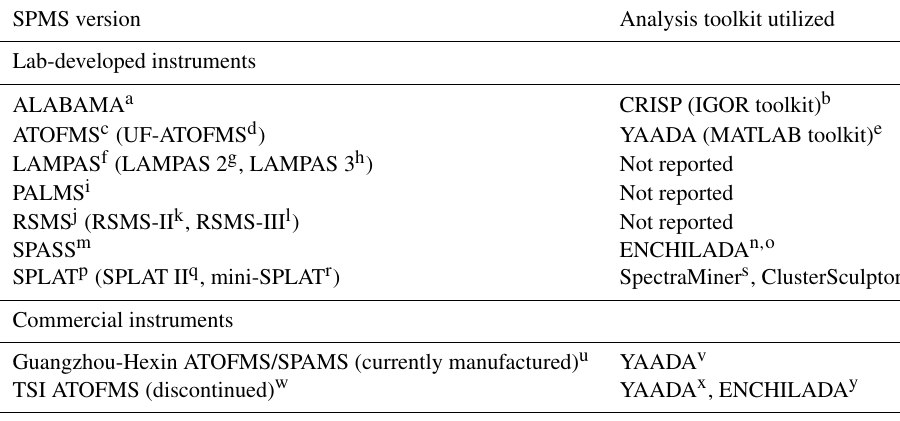
Table 1. Summary of SPMSs developed and data analysis packages